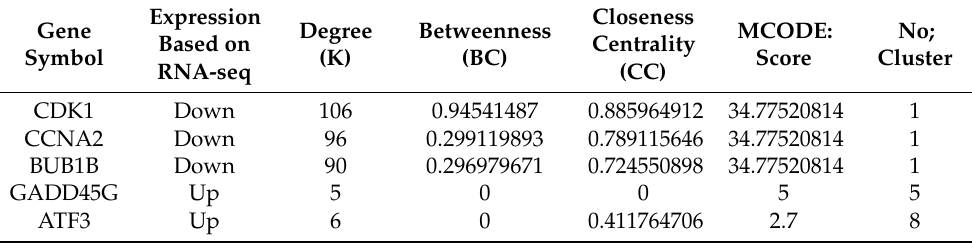
Figure 4. Overview of PPI network and subnetworks (modules). The PPI network ( A ); the yellow colors represent key nodes (highest BC and K) in PPI networks. Generally, 10 modules were obtained from the main network and module 1 ( D ), module 2 ( B ) and module 3 ( C ) are significant modules. Module 1 with the score of 47.057 and 54 nodes is the more significant module, covering three genes CDK1, CCNA2, and BUB1B with the highest BC and K in the PPI network and with the highest score in the MCODE plug-in. Table 3. The position of 5 CRC-related candidate genes in the PPI network and subnetworks (mod- ules). As shown, CDK1, CCNA2 and BUB1B genes with the highest degree (K) and betweenness (BC) are clustered in subnetwork 1, demonstrating their significant influence in the network. In contrast, GADD45G and ATF3 genes are classified in clusters 5 and 8, perhaps indicating their independence to the networks in